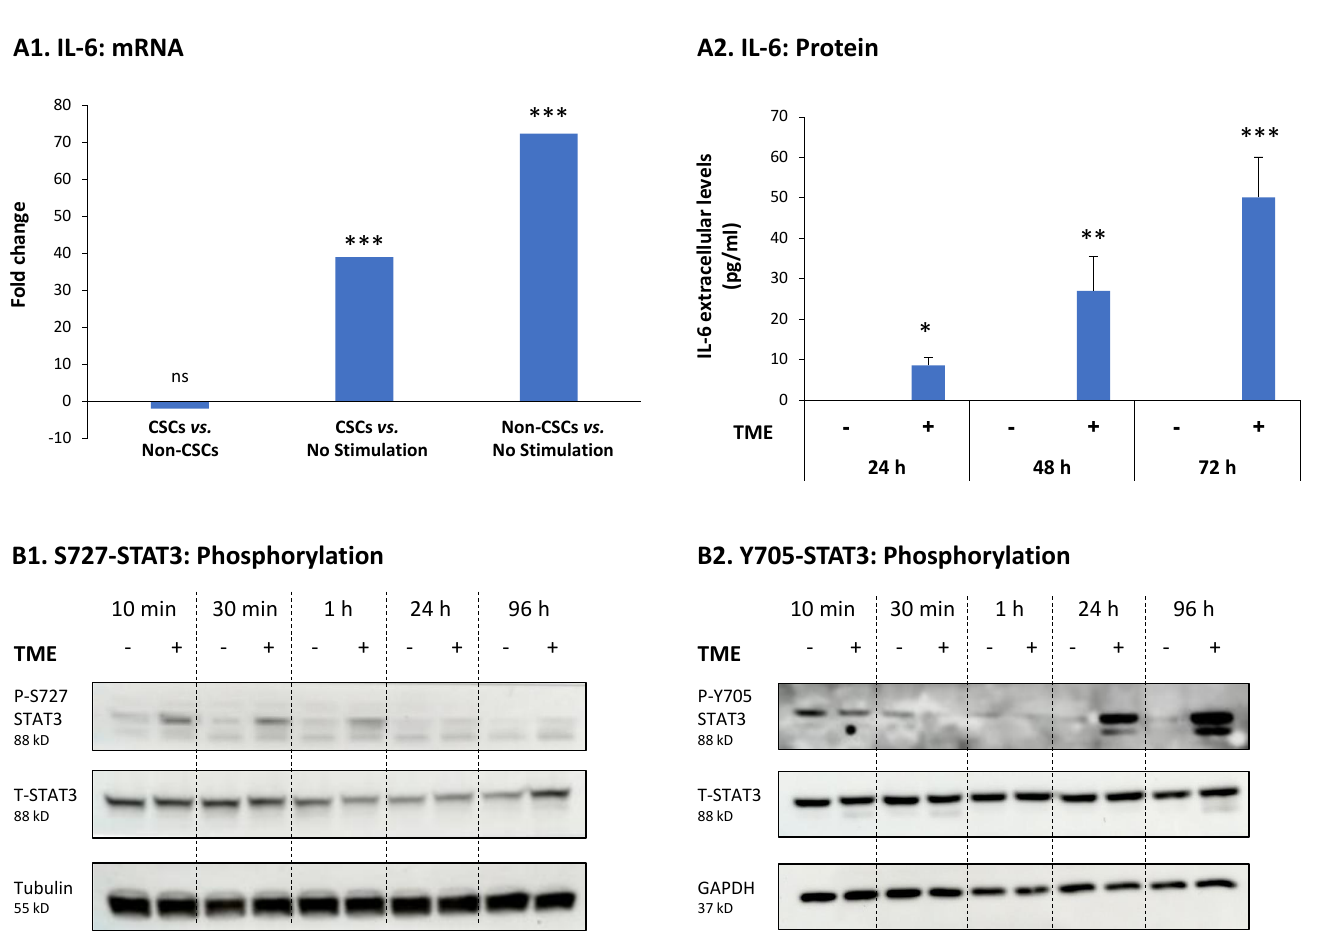
Figure 4. TME Stimulation leads to up-regulation of IL-6 expression, and to phosphorylation of STAT3 at the S727 and Y705 phosphorylation sites in HR+/HER2 − breast cancer cells: MCF-7